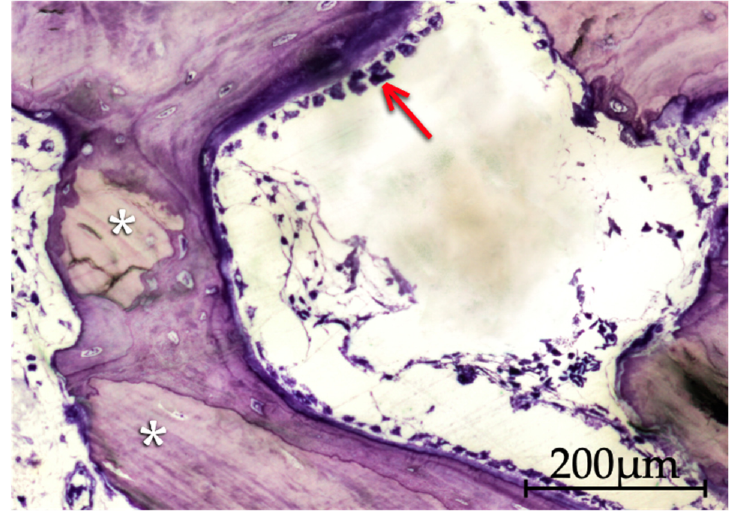
Figure 5. Histological aspect of mp3 particles at 15 days of evolution, surrounded by new apposition formed bone. The presence of a substantial number of osteoblasts indicates that synthesis activity is still ongoing. The image shows bone trabeculae containing several osteointegrated particles (asterisk) and a peripheral zone with prominent osteoblastic activity (arrow) (200 × original